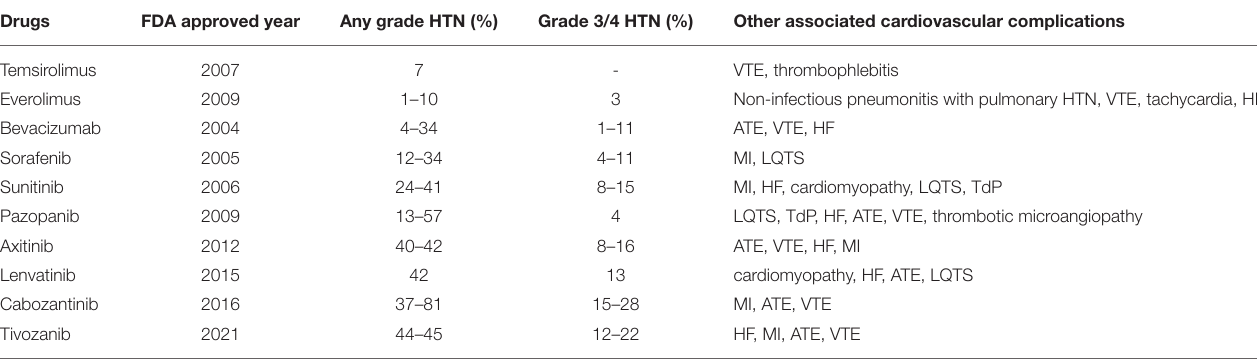
TABLE 1 | Incidence of targeted therapy associated hypertension (HTN) in patients with metastatic renal cell carcinoma